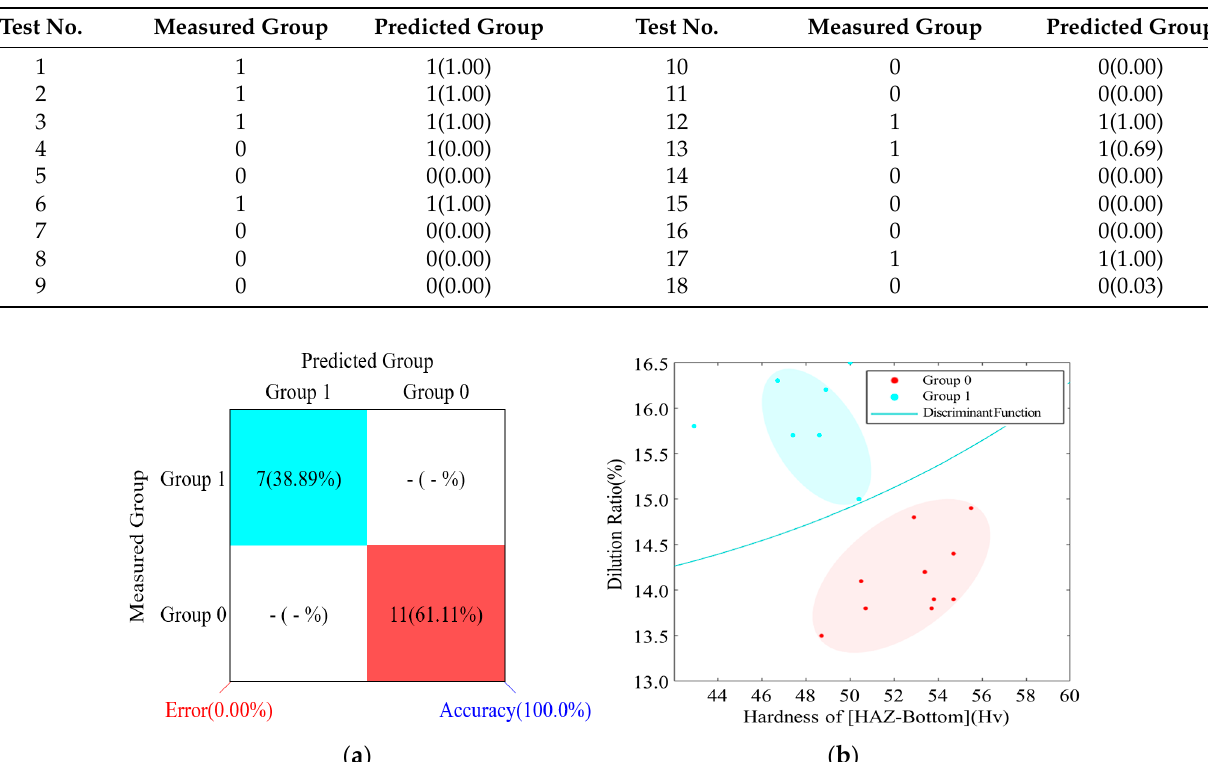
Figure 8. Weldment hardening discriminant in flux cored arc welding: ( a ) Performance evaluation for SVM and ( b ) Discriminant graph for SVM.